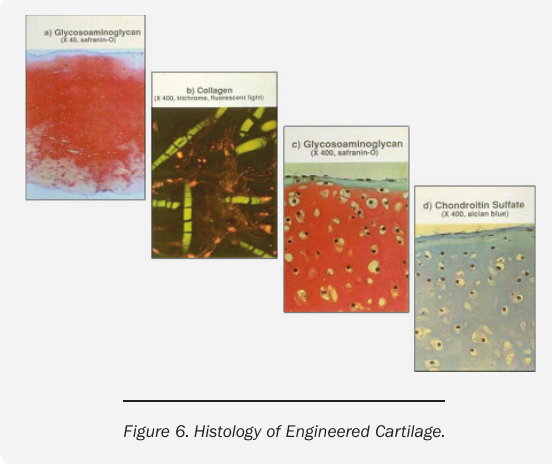
Figure 6. Histology of Engineered